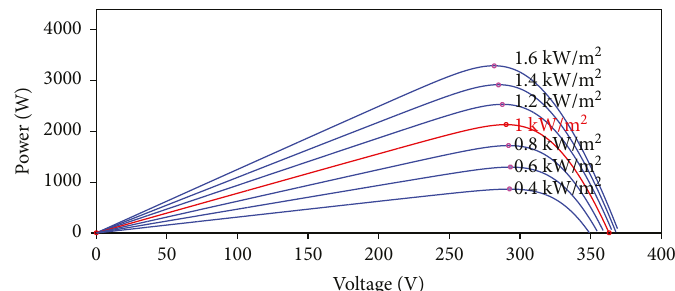
Figure 1: Power characteristics of a PV